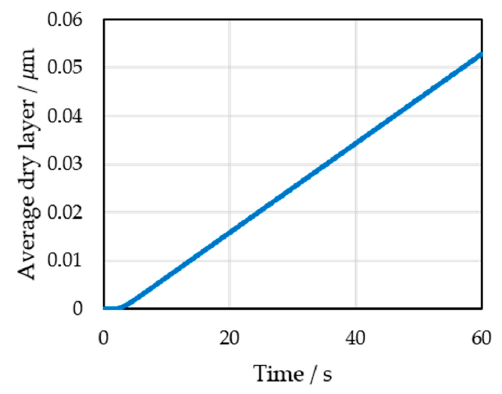
Figure 12. Average dry layer of the particles coated with the Pharmacoat 606 solution.